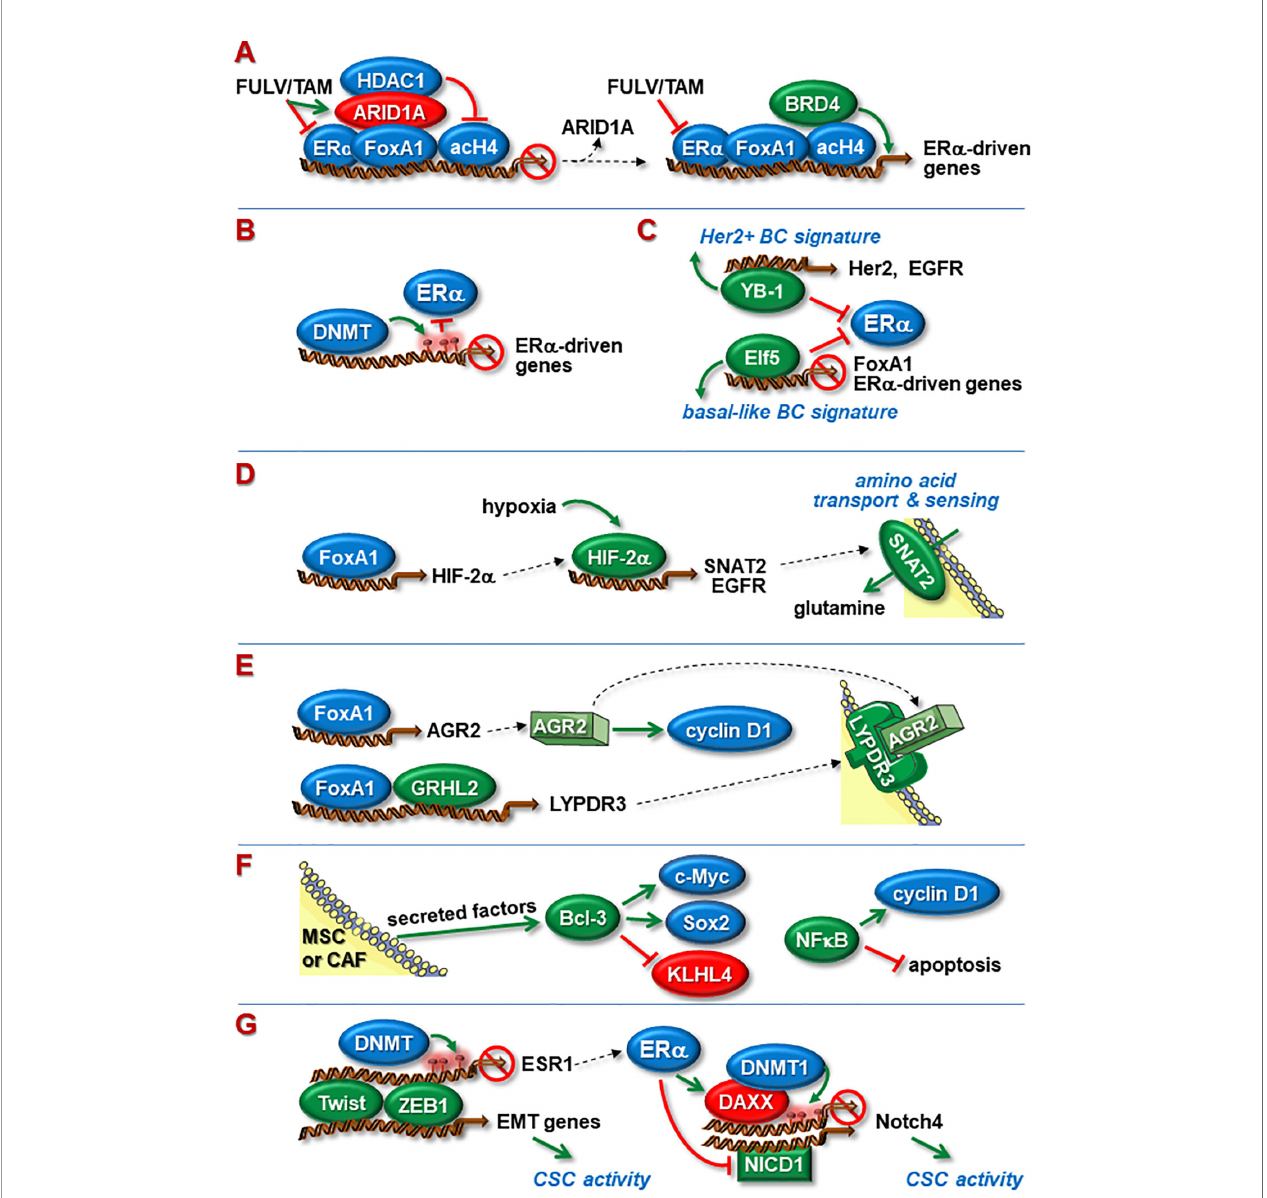
FIGURE 2 | Nuclear proteins involved in ENDO-R. (A) Blockage of ER a function by FULV or TAM causes ARID1A to bind to FoxA1 leading to transcriptional inhibition of ER a -driven genes by recruitment of HDAC1. Dysfunctional ARID1A leads to higher abundance of acetylated histone 4 (acH4) and recruitment of BRD4, able to active transcription despite the presence of anti-estrogens. (B) ENDO-R often coincides with DNMT-mediated DNA methylation of ER a -driven genes at promoters and/or enhancers, resulting in blockage of ER a binding to these sites. (C) Acquisition of ENDO-R by transcriptionally re-programming cells. YB-1 suppresses ER a activity and upregulates the expression of Her2 and EGFR leading to a Her2-driven transcriptional pattern. Elf-5 inhibits the expression of ER a and FoxA1 and fosters a transcriptional pattern typically seen in basal-like breast cancer. (D) Hypoxia promotes ENDO-R by activating HIFs. FoxA1-regulated HIF-2 a stimulates the transcription of EGFR and SNAT2, the latter being a transmembrane transporter and sensor of amino acids. Anti-estrogen resistant cells may use SNAT2-imported glutamine as a major carbohydrate source to maintain metabolism. (E) Independent of ER a , FoxA1 can stimulate the transcription of AGR2 and, in cooperation with GRHL2, the transcription of LYPDR3. AGR2 can cause the cyclin D1 synthesis to rise. FoxA1, GRHL2, LYPDR3 and AGR2 may act in concert to induce ENDO-R. (F) Members of the NF к B/I к ;B family may be involved in ENDO-R. NF к B supports ENDO-R by stimulating cyclin D1 expression and by inhibiting apoptosis. Bcl-3, whose expression in BCs is induced by MSC- and CAF-secreted factors, causes higher expression of proliferation-stimulatory c-Myc and anti- apoptotic stem cell factor Sox2 and blocks proliferation-inhibitory KLHL4. (G) Twist and ZEB1 can enhance CSC activity by inducing EMT. Additionally, Twist and ZEB1 can suppress ER a expression by recruiting DNMT to the esr1 promoter. ER a may limit CSC activity by suppressing the transcription of Notch4. One way involves induced expression of the transcriptional repressor DAXX followed by DNMT1-dependent methylation, another down-regulated abundance of Notch1- derived NICD1, a positive regulator of Notch4 transcription. Green and red ovals indicate proteins that promote or inhibit anti-estrogen resistance, respectively. Green arrows indicate a positive, red T-shaped symbols a blocking effect. Red circles denote CpG